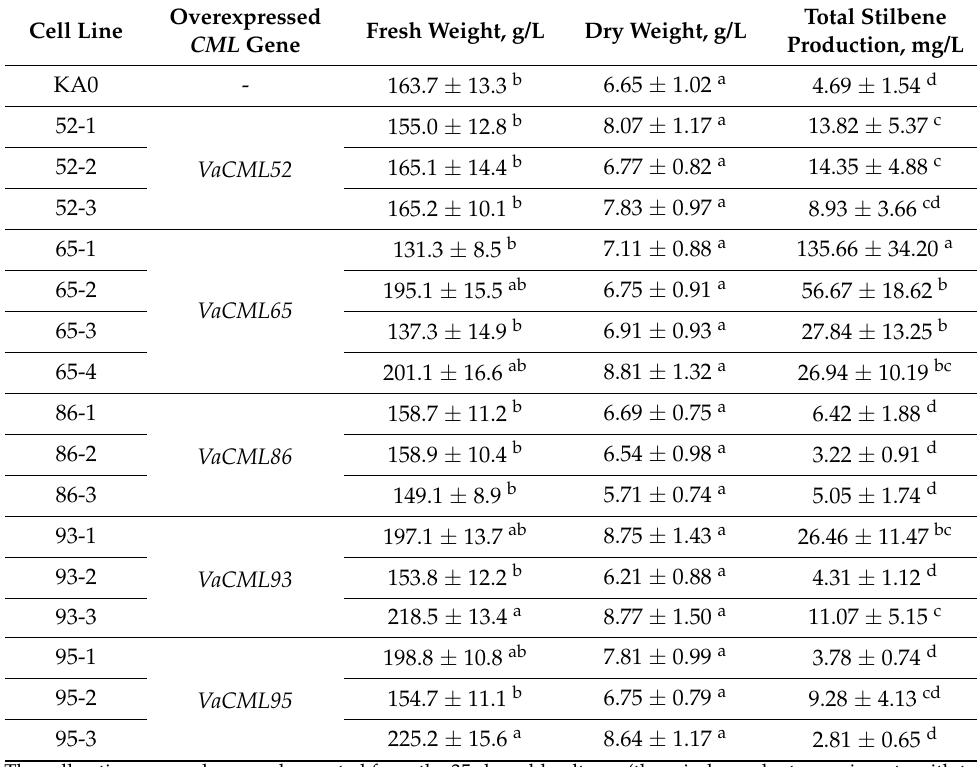
Table 1. Biomass accumulation and total stilbene production in the cell lines of Vitis amurensis overexpressing the VaCML52 , VaCML65 , VaCML86 , VaCML93 , or VaCML95 genes. Cell Line